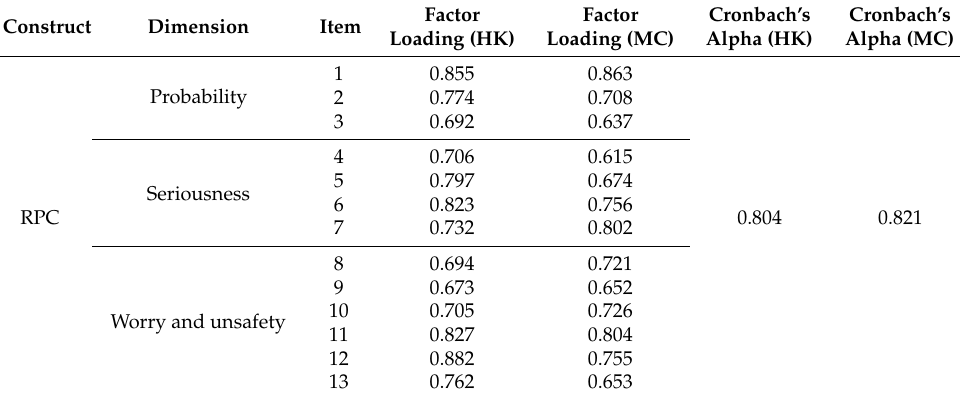
Table 3. Statistical Analysis of the SC and SCB performances of construction